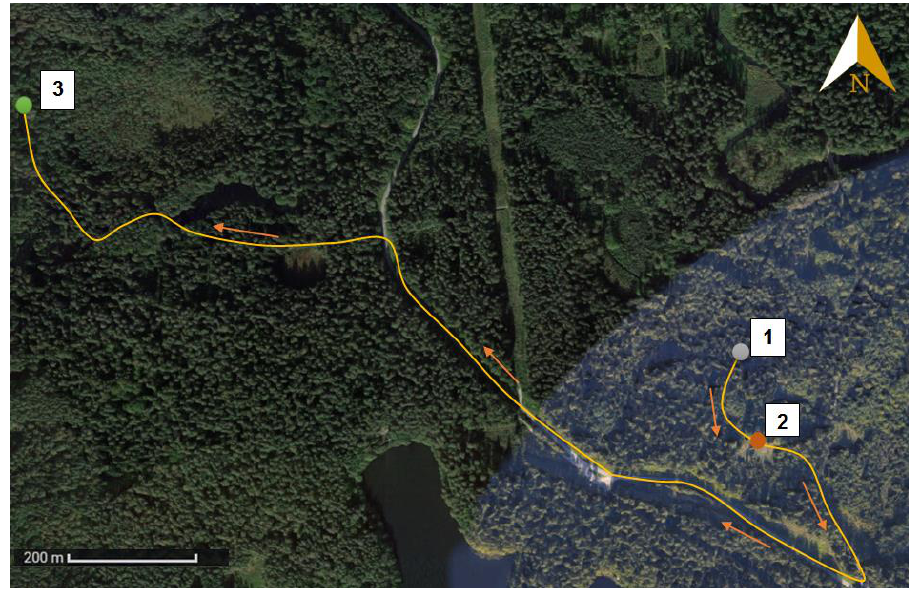
Figure 1. The walking route at the nature reserve Redykajny during the forest recreation program. Colored points indicate places intended for recreational activities. Points of stay are numbered from the start (Area 1) to the end (Area 3) of the walk. Map provided by F.